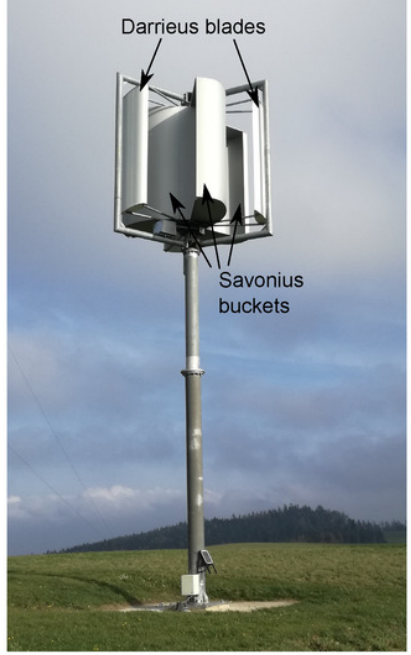
Figure 7. H-Darrieus turbine with hybrid rotor configuration